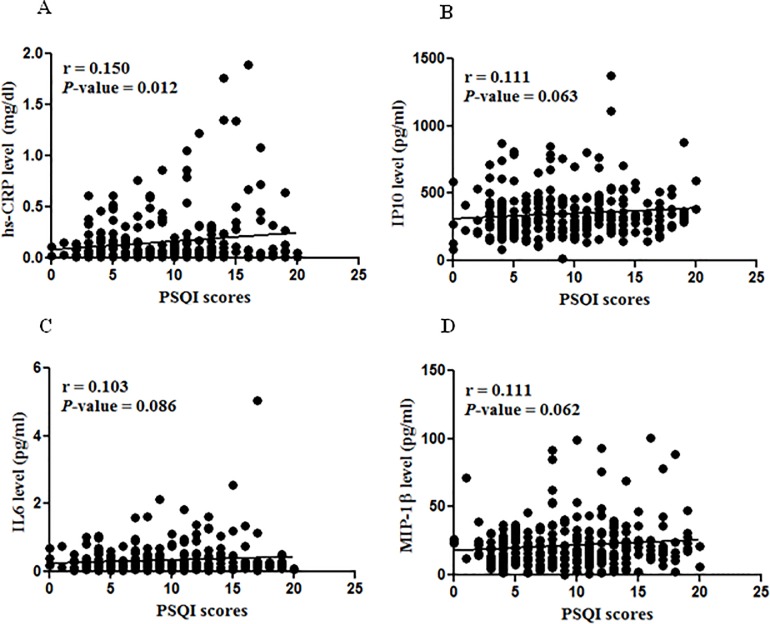
Correlation between PSQI scores and inflammatory factors.Pittsburgh Sleep Quality Index (PSQI) scores correlated with high-sensitivity C-reactive protein (hs-CRP) (A), interferon-inducible protein-10 (IP-10) (B), interleukin 6 (IL6) (C), and macrophage inflammatory protein-1beta (MIP-1β) (D) at P values less than 0.1 using Pearson’s correlation analysis.